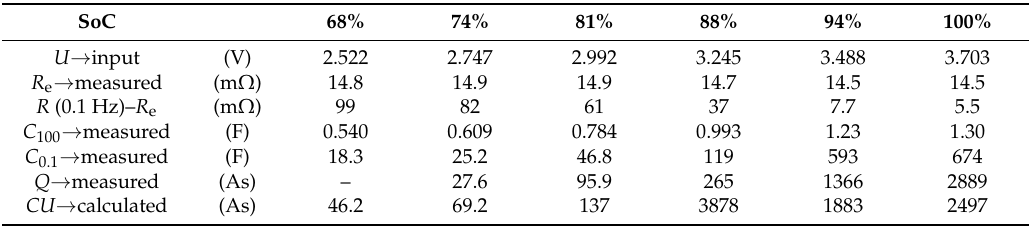
Table 2. Correlation between state-of-charge (SoC) and capacitance for a lithium-ion battery (Samsung